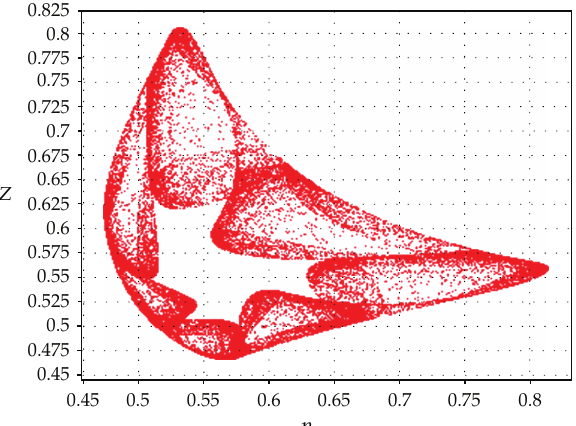
Figure 11: Chaotic attractor for the generalized grab the dollar game (cid:3) x = 0.21 (cid:4)